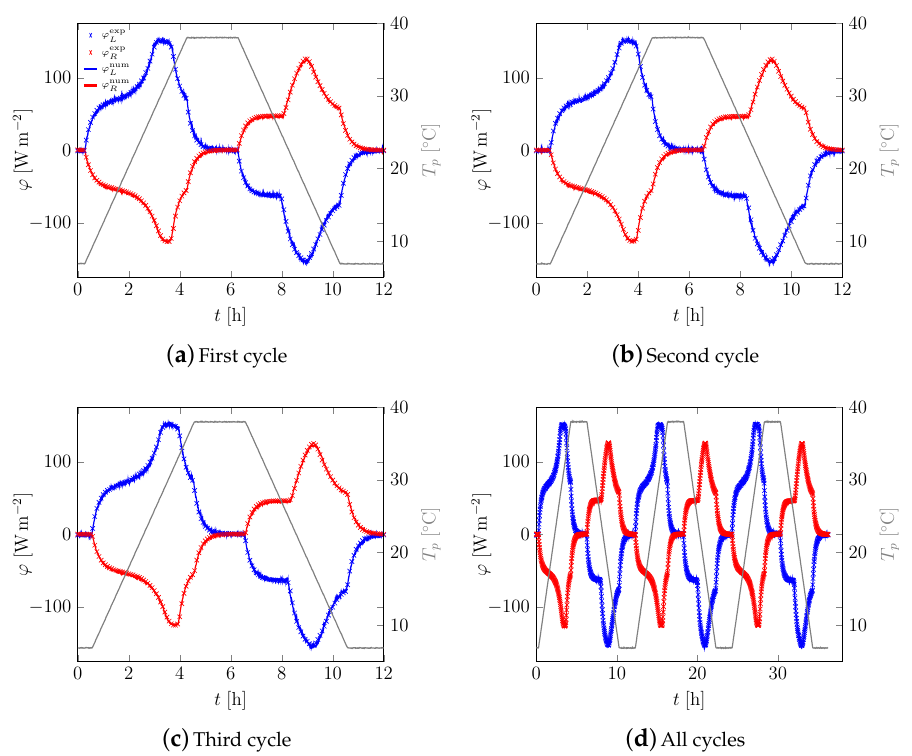
Figure A6. 19.2% w -PCM mortar: comparisons of the experimental fluxes with the numerical ones after identification for the 4h heating/cooling ramp experiment.